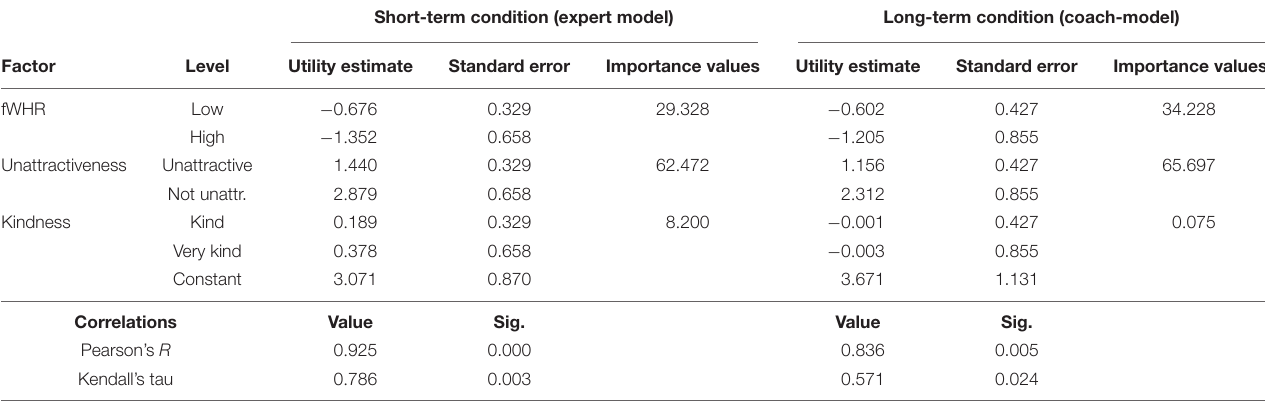
TABLE 2 | Results conjoint analysis ( n = 381) in both the short-term and the long-term condition. Short-term condition (expert model)